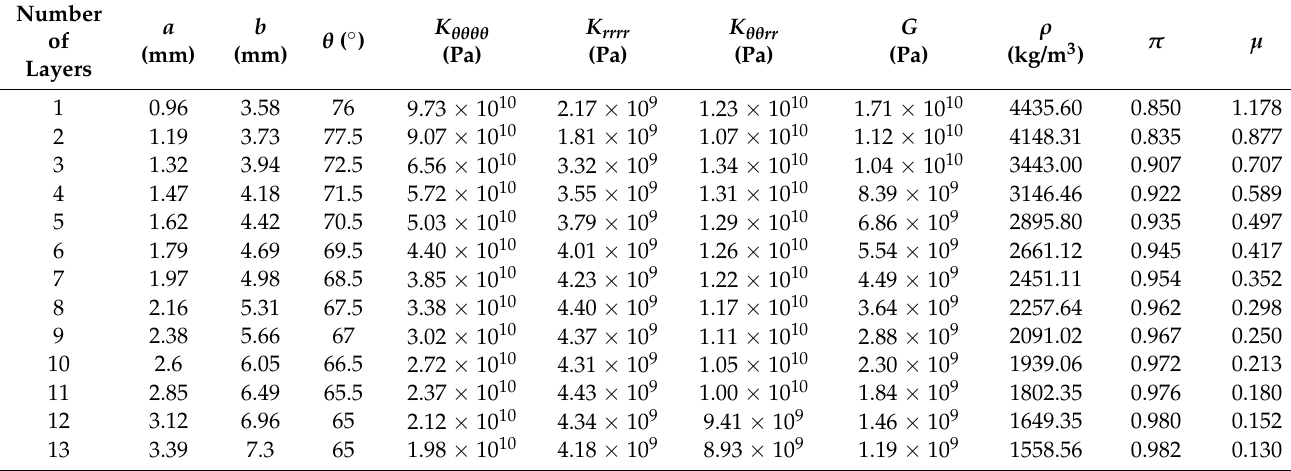
Table 1. Structural dimensions and parameters of the test